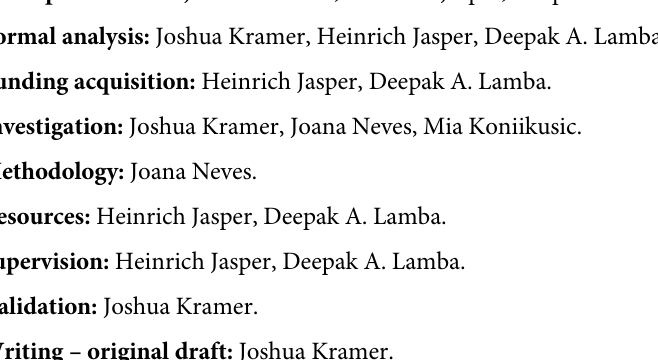
S4 Fig. UV exposed Sep::G4;Smox and MadRNAi individual progeny DCP1+ Elav+ cells to UV Sep WT. Error bars indicate s.e.m.; P-values from Student’s t-test. � p < 0.05, �� p < 0.01, �� p < 0.001. S5 Fig. pSmad 1/5/9 (BMP) and pSmad 2/3 (TGFB) control images of C57 animals (S5-A). TUNEL stain in red of BALB/c animals post light exposure, with DAPI in blue (S5-B). PBS WT Control unexposed retina with IBA1 in white and CD68 in green (S5-C). pSmad 1/5/9 representative images of BALB/c animals post light exposure at 0, 24 and 36 hours (S5-E). Rep- resentative images of DT injected CD11b::DTR mice with pSmad 1/5/9 (BMP) in red, and CRALBP in white (S5-E). Scale Bar: 30 μ